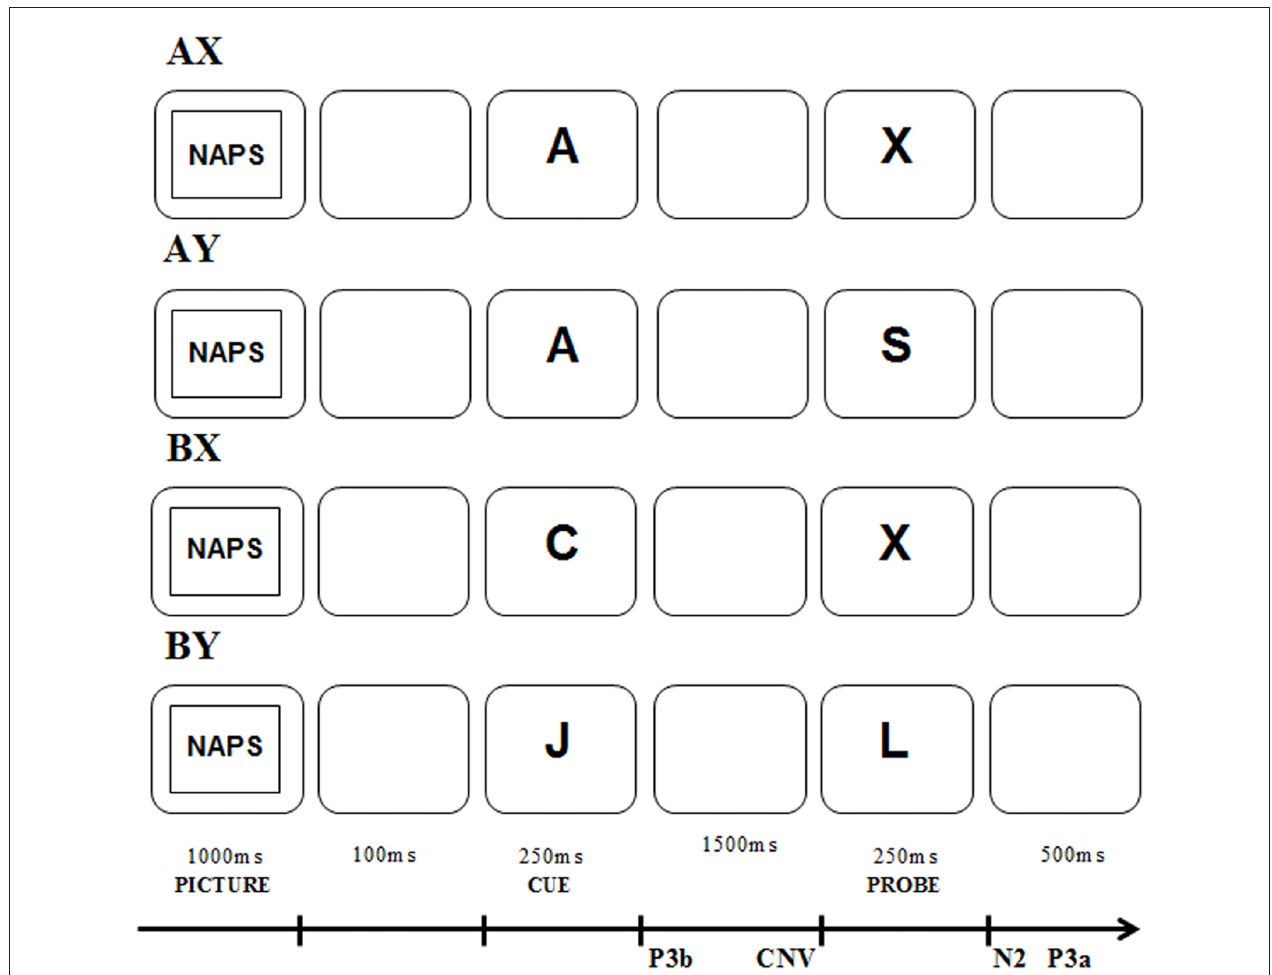
FIGURE 1 | The AX-Continuous Performance Task (AX-CPT) procedure with the four types of sequences occurring in the